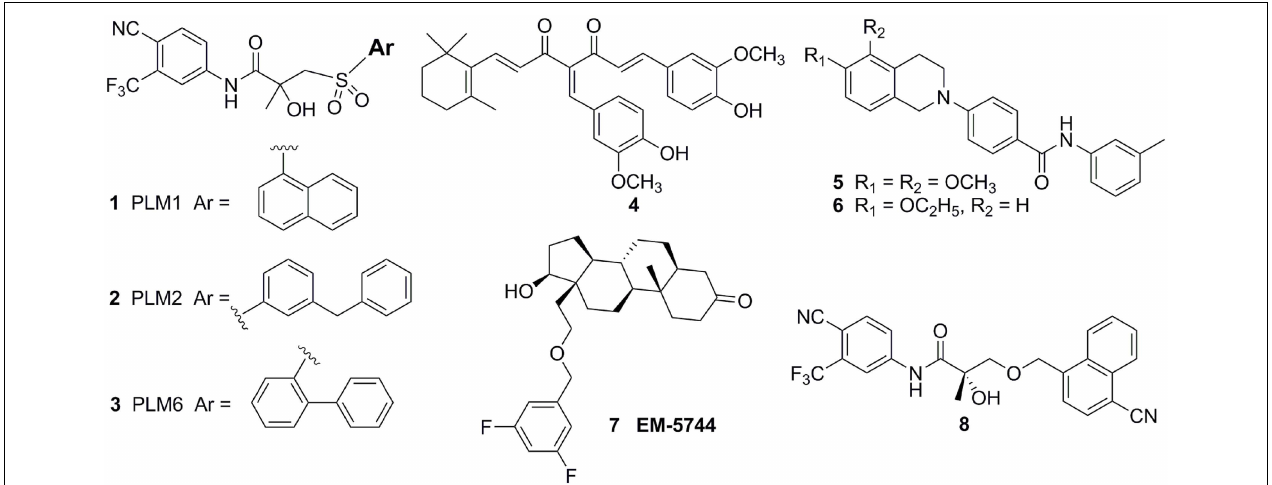
FIGURE 4 | Chemical structures of AR Antagonists and Agonists designed by using bulky group strategy.